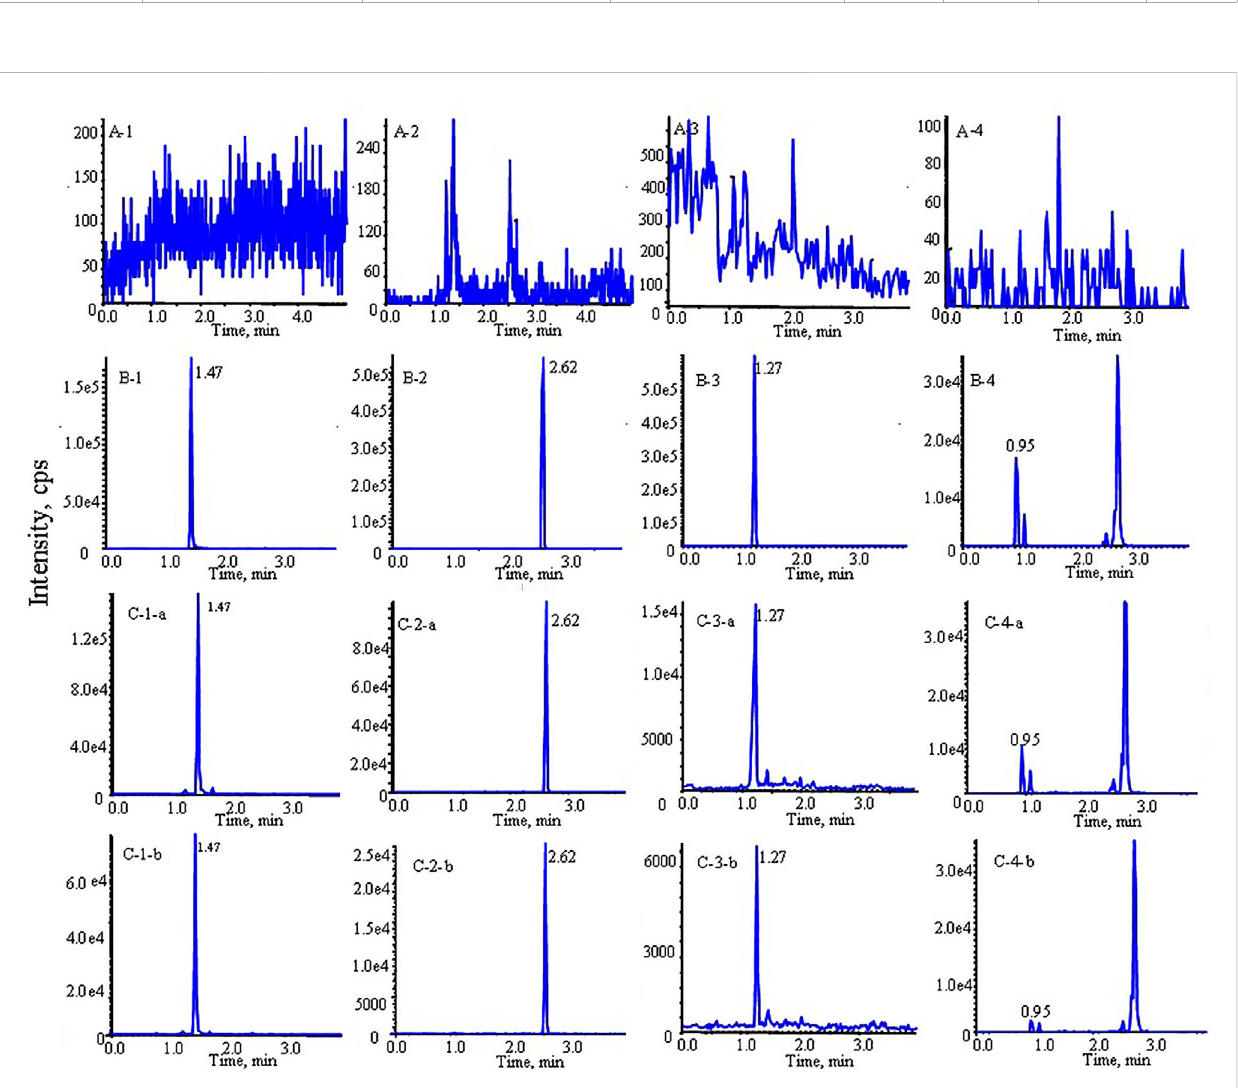
FIGURE 2 Typicalmultiplereactionmonitoring(MRM)chromatogramsofmorin,morusin,umbelliferoneandmulberrosideAfromratplasma: (A) blankplasma sample; (B) blank plasma spiked with analytes; (C) rat plasma sample after oral administration of Mori Cortex total fl avonoid extract (1: morin, 2: